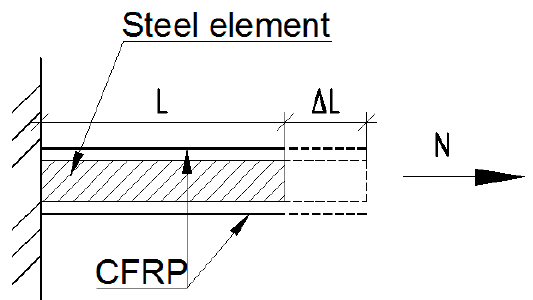
Figure 5. Strains in a stretched strengthened steel specimen.